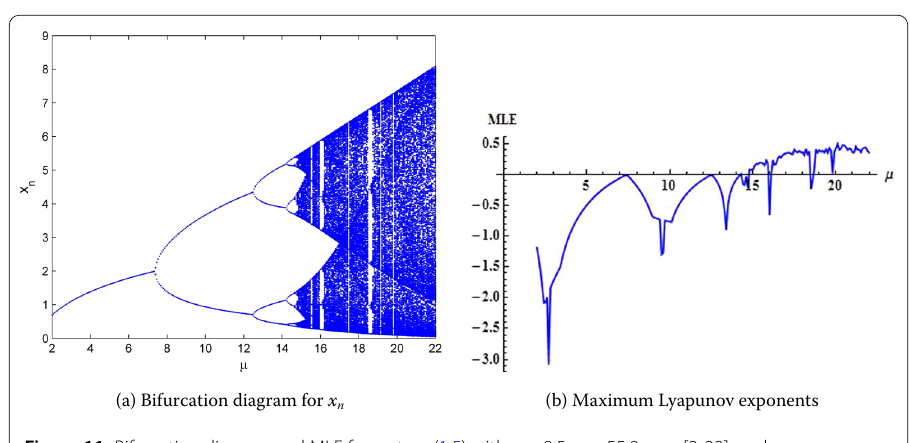
Figure 11 Bifurcation diagram and MLE for system (1.5) with ν = 8.5, η = 55.8, μ ∈ [2,22], and ( x 0 , y 0 ) = (2.72,0.83)